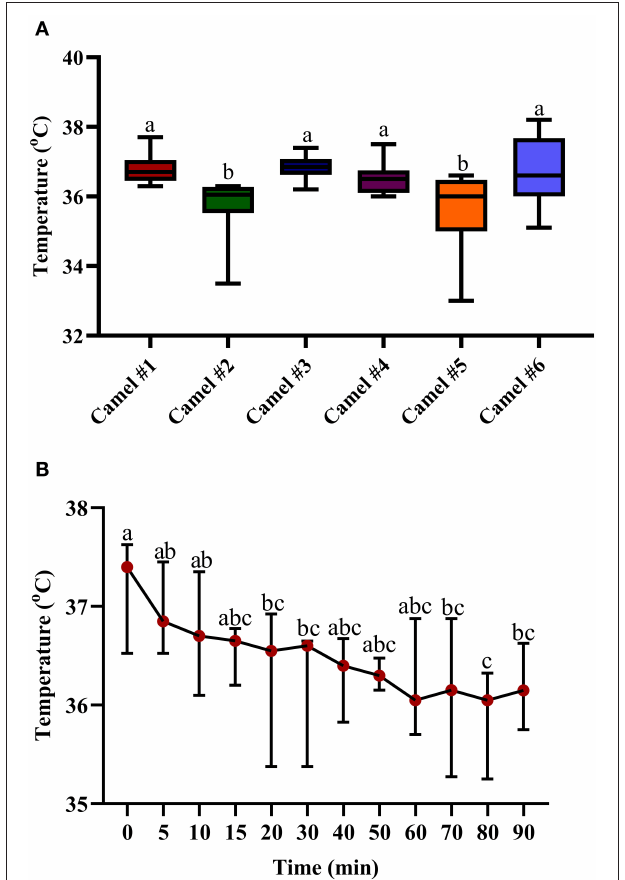
FIGURE 4 | The changes in the respiratory rate (breath/min) in camels after injection of acepromazine (0.1 mg/kg i.v.). (A) Boxplot showing respiratory rates (breath/min) with all data points represented. (B) The median respiratory rates (beats/min) 90min after acepromazine injection. Median values in each plot followed by a different lowercase letter (a, b, c) are significantly different by the Duncan test at p ≤ 0.05.